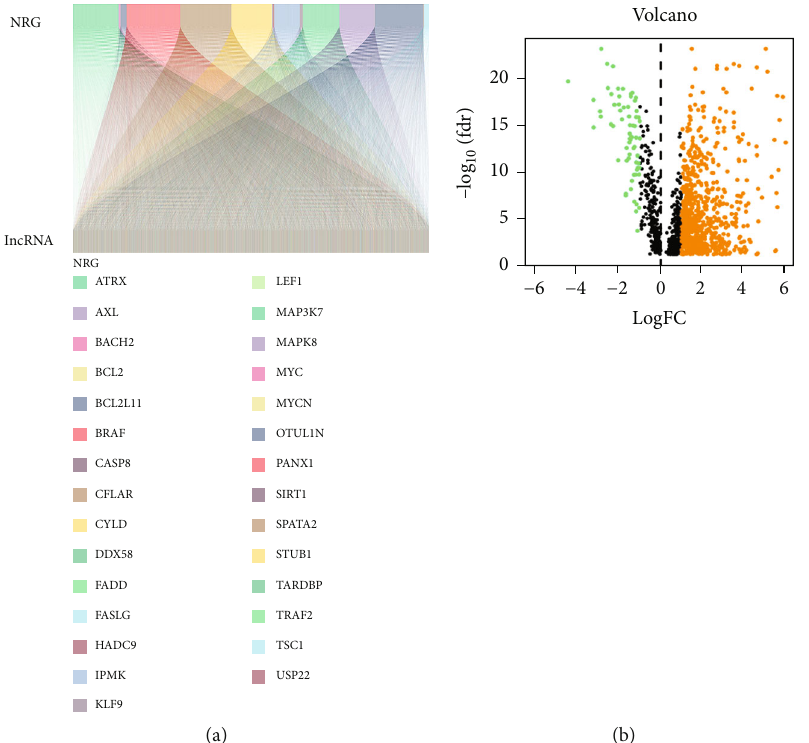
Figure 2: Extraction of necroptosis-related lncRNAs in CRC patients. (a) The Sankey diagram of necroptosis-related genes (=67) and related lncRNAs (=1425) (correlation coe ffi cients > 0.5 and P < 0 : 001 ). (b) The volcano plot of 747 di ff erentially expressed necroptosis- related LncRNAs. (LogFC > 1 and DFS <